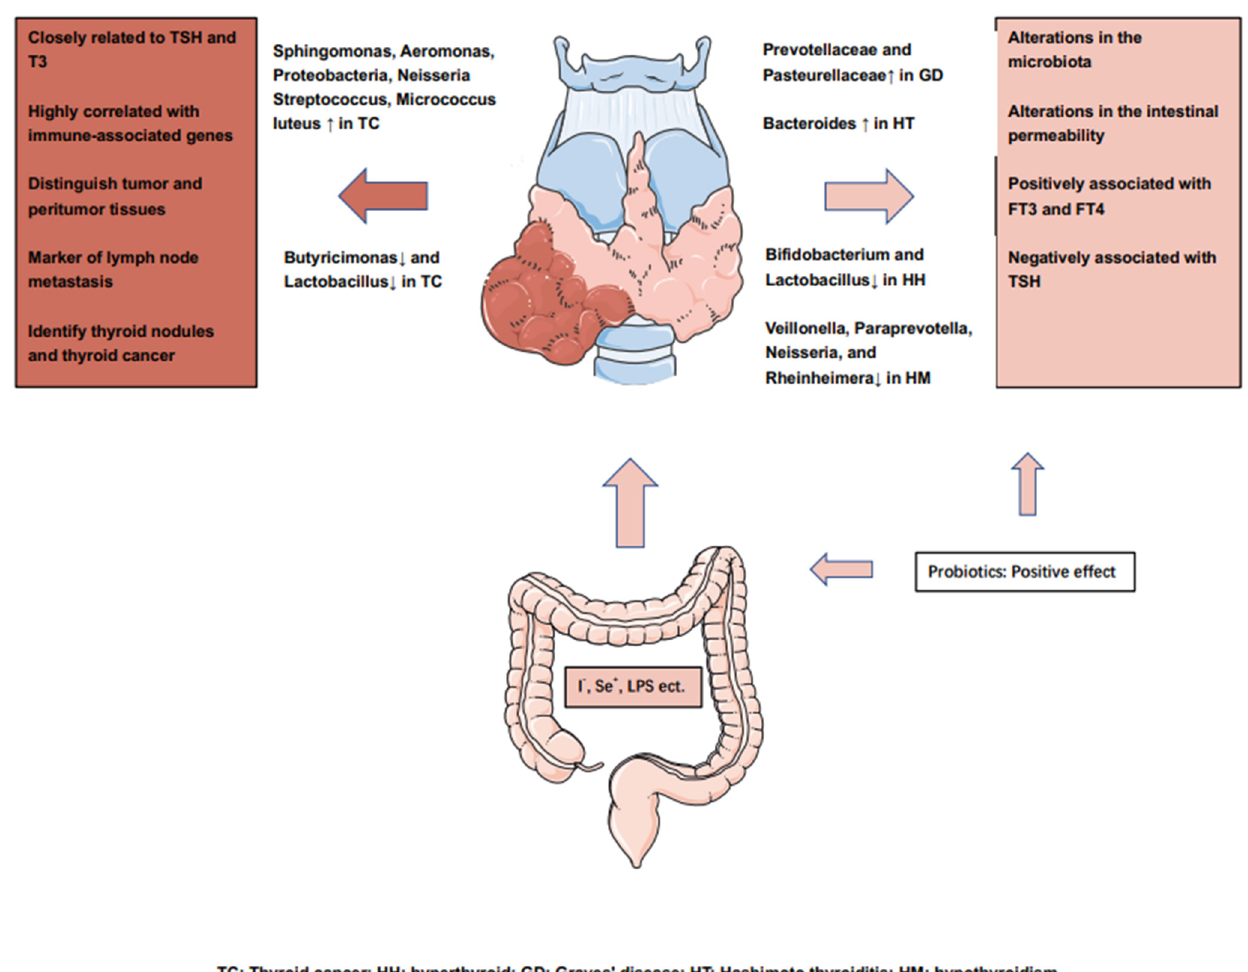
Figure 2. Overview of the influence of the gut microbiota on the thyroid cancers or thyroid diseases.